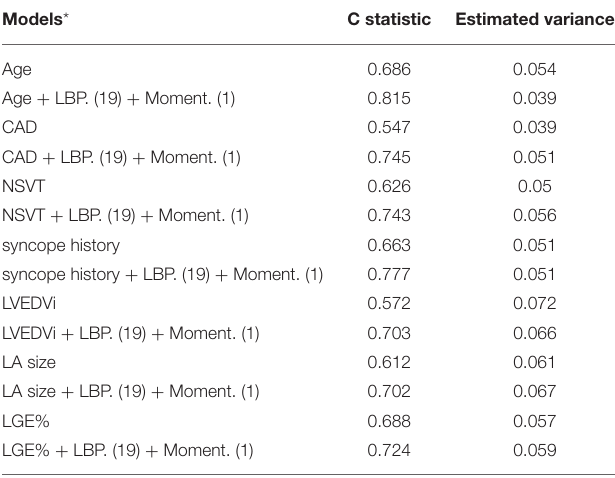
TABLE 3 | Comparisons of models including univariately significant risk predictors and selected radiomics features for SCD prediction by C statistic in participants with HCM.